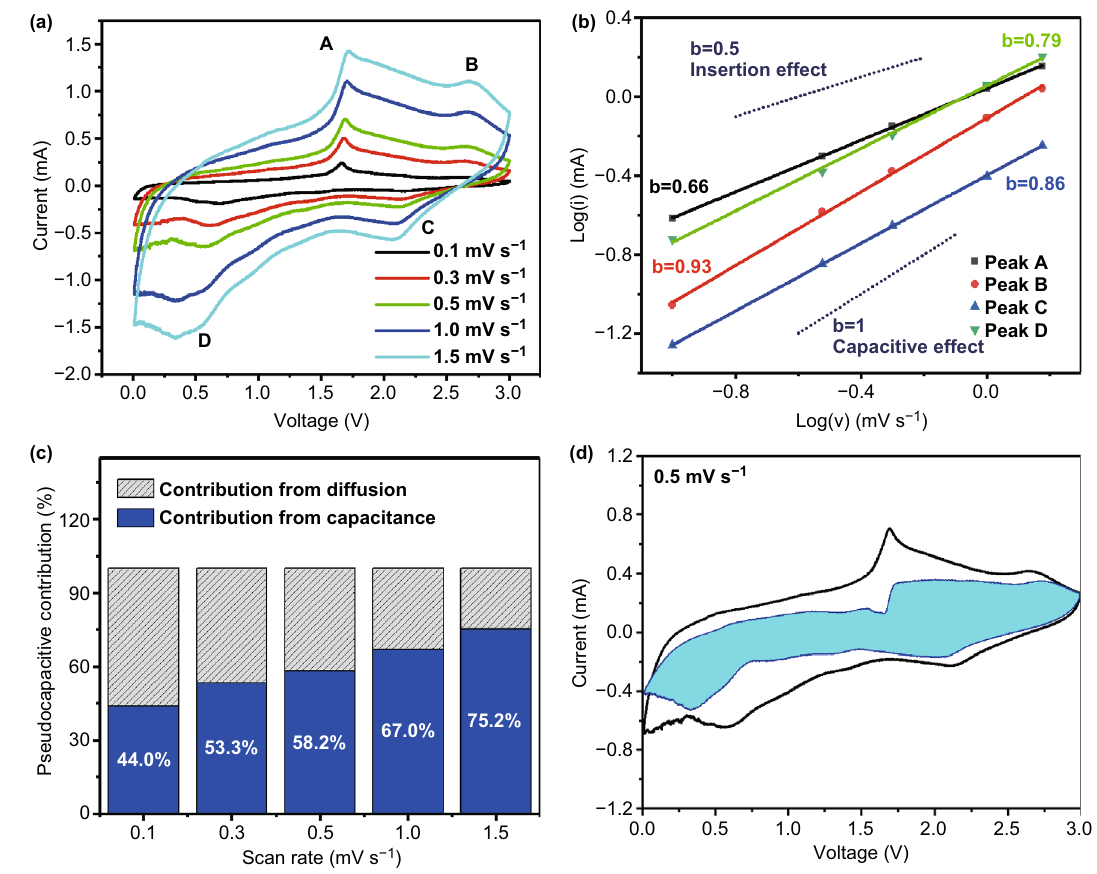
Fig. 6 Kinetics analysis for the FePS 3 @MXene-1 electrode. a CV profiles at diversity scan speeds. b b-value calculation based on the relevance between peak currents and velocity of scanning. c Normalized contribution ratio of capacitive and diffusion-controlled capacities. d Proportion of capacitive (shaded region) contribution at 0.5 mV s −1